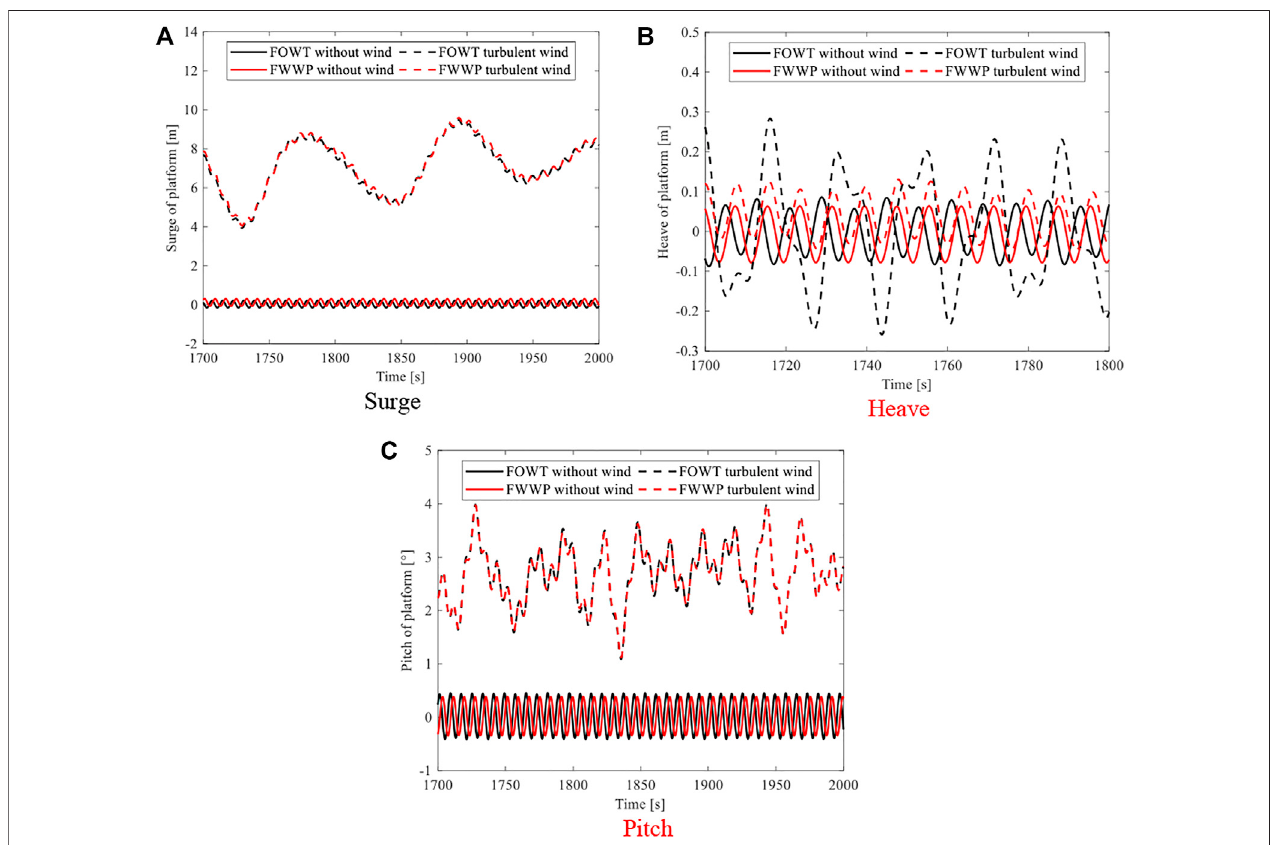
FIGURE 12 | Platform motion in both the FOWT and FWWP. (A) Surge. (B) Heave. (C) Pitch.